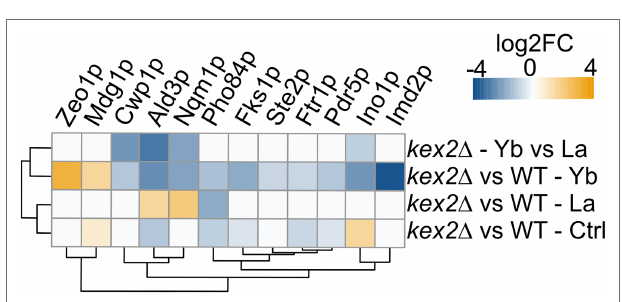
FIGURE 7 | Heatmap displaying protein abundance changes in kex2 ∆ compared to the WT. Please, refer to the Supplementary text for information related to proteomics data acquisition and